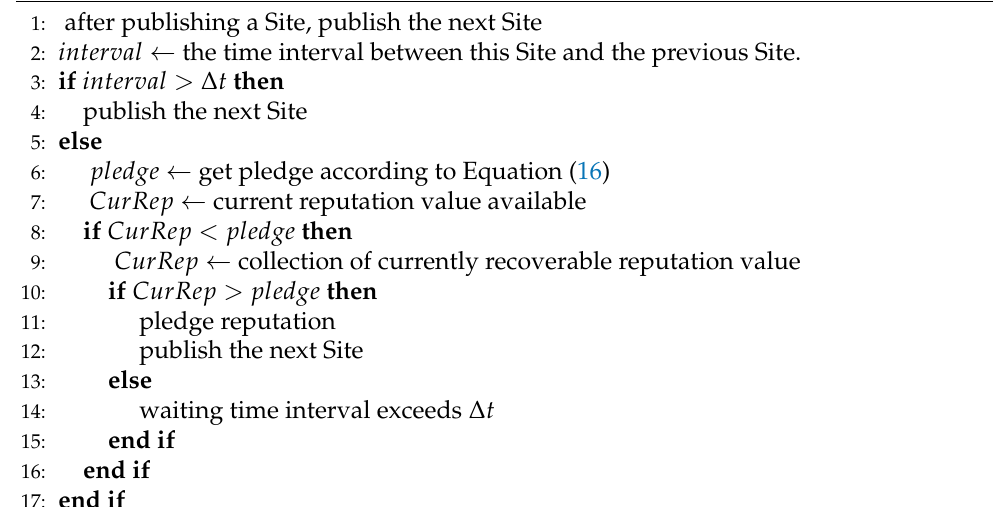
Protocol 1 Reputation Value Management Smart Contrast